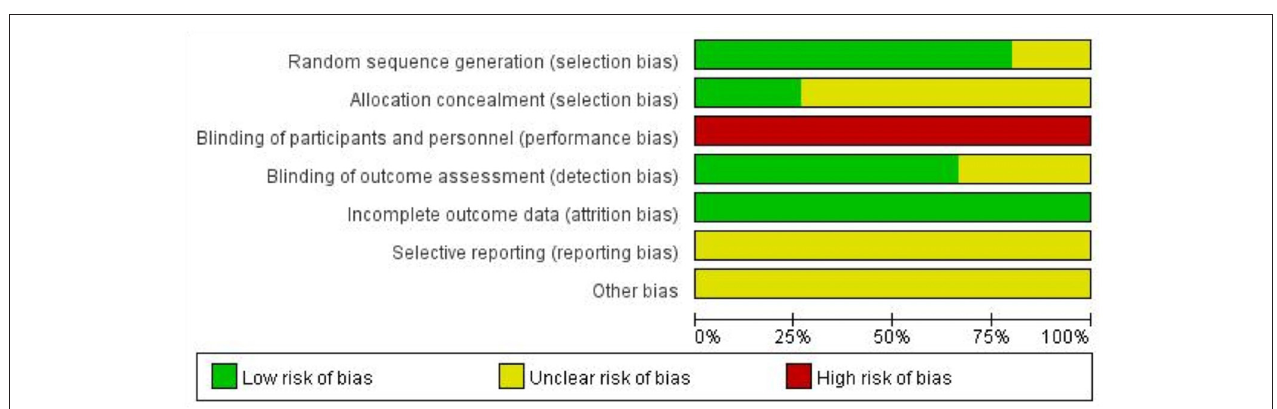
FIGURE 2 | The assessment of risk of bias in the included